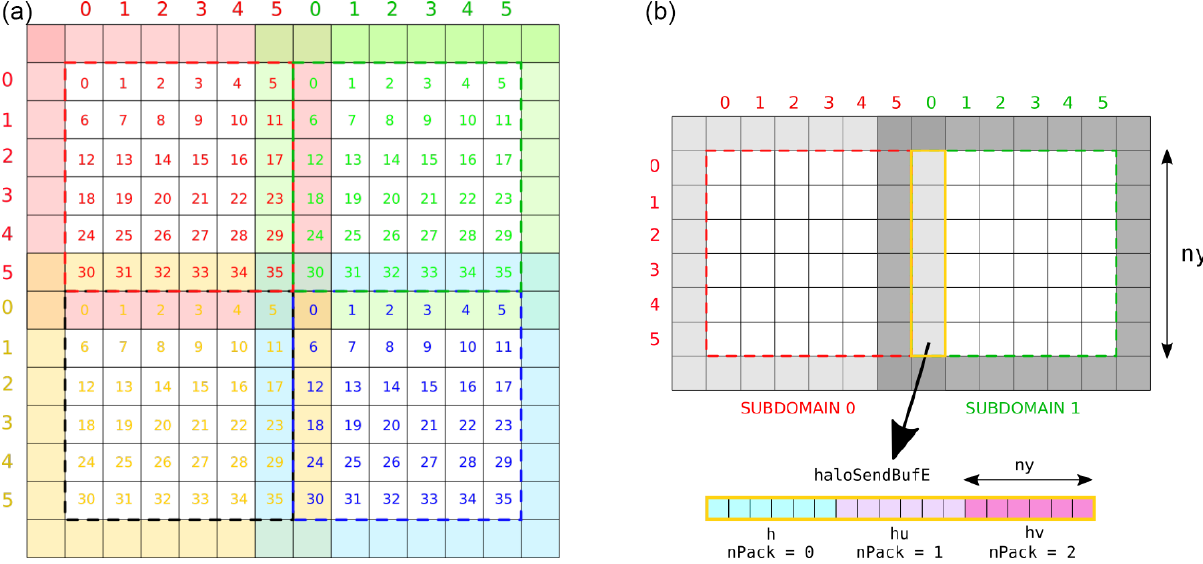
Figure 3. Data exchange between subdomains in SERGHEI: in the global surface domain, subdomains overlap with each other through their halo cells (a) . These halo cells are used to exchange data between the subdomains (b)